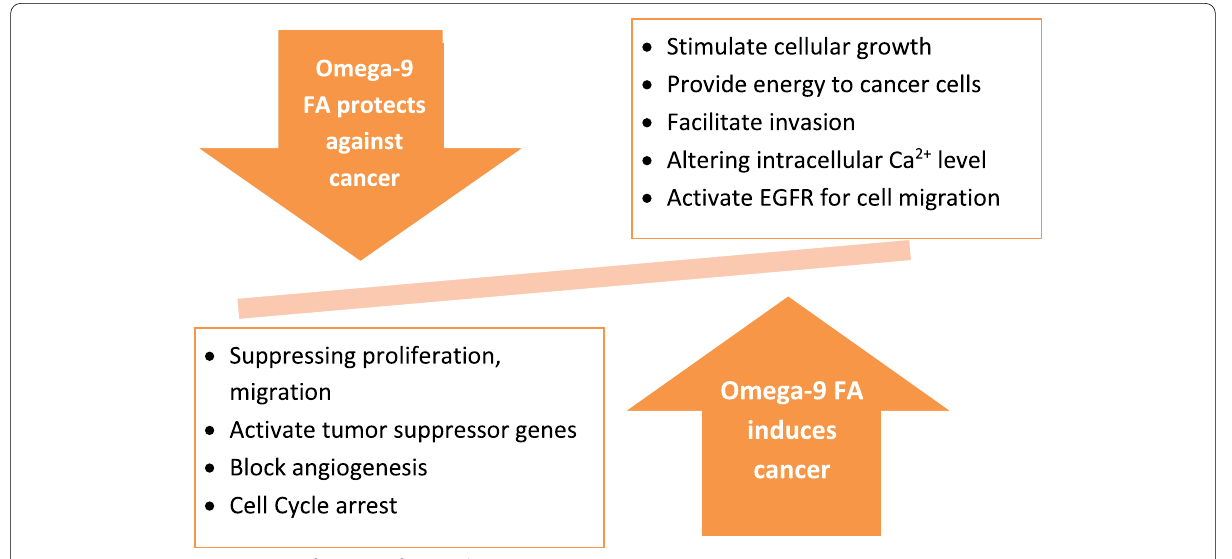
Fig. 5 Anti- or pro-cancer actions of omega-9 fatty